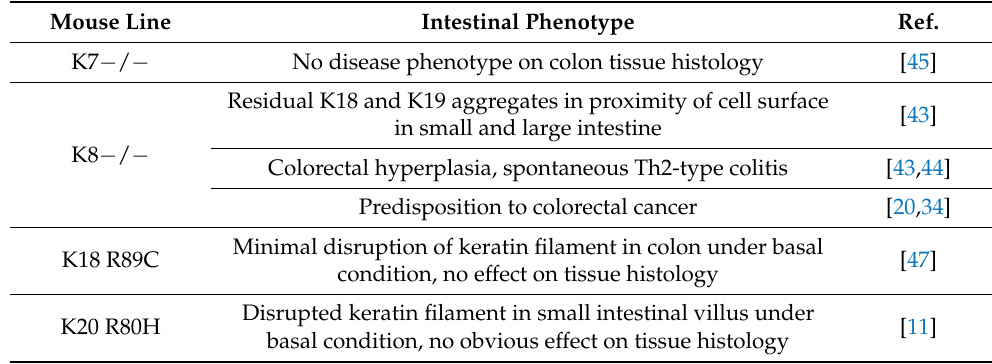
Table 2. Intestinal phenotypes of keratin-related mouse models. Mouse